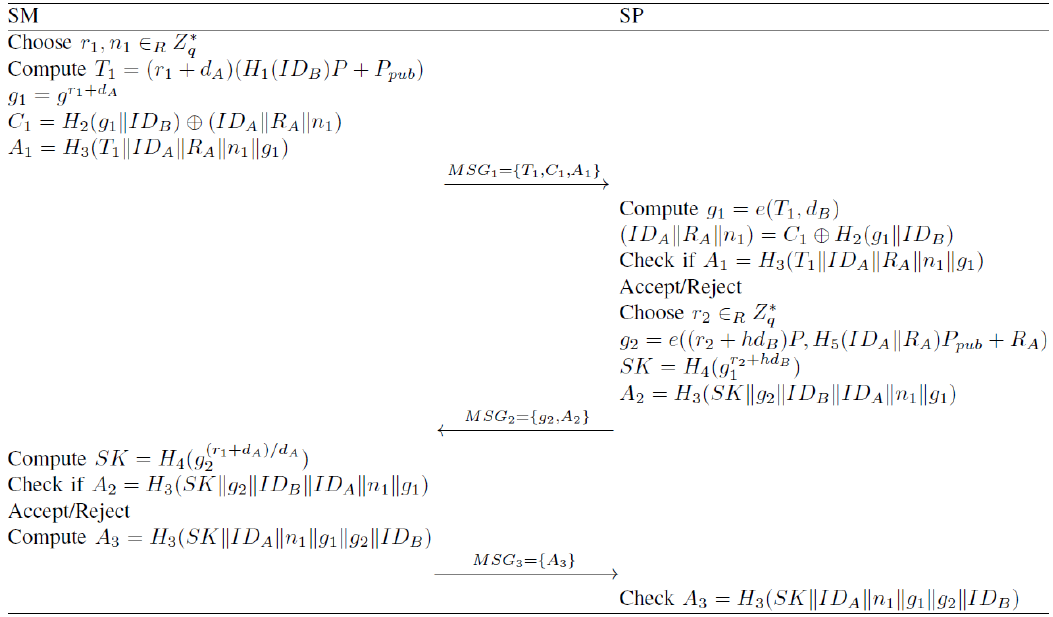
Figure 2. Steps and computations in the key agreement phase of